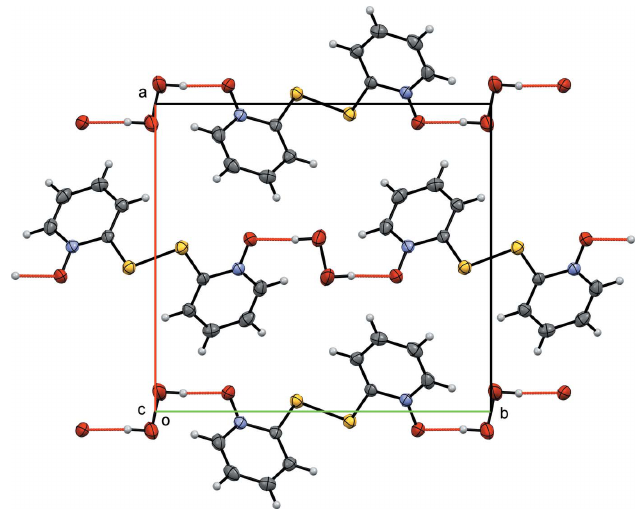
Figure 2 Crystal packing diagram of title compound viewed along [001]. Hydrogen bonds are colored